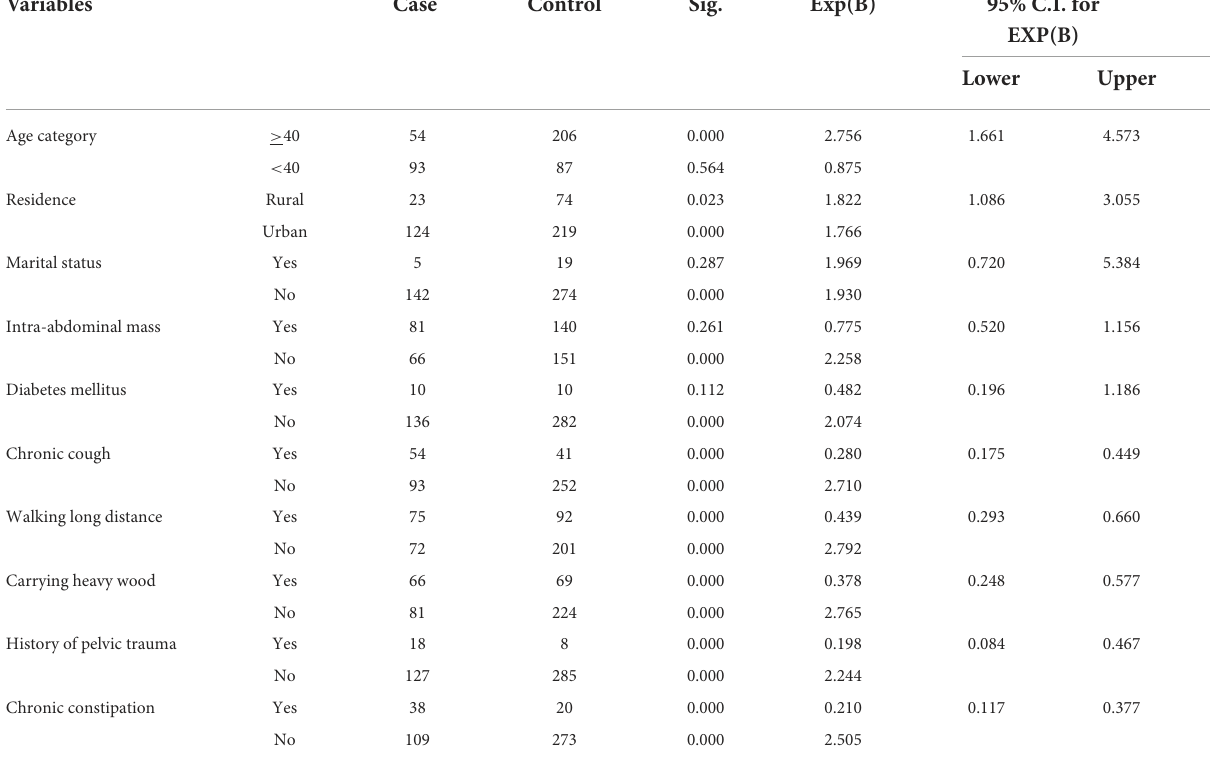
TABLE 2 Bivariable analyses of sociodemographic, medical, and other risk factors of POP at ATRH, 2021. Variables Case Control Sig. Exp(B) 95% C.I. for